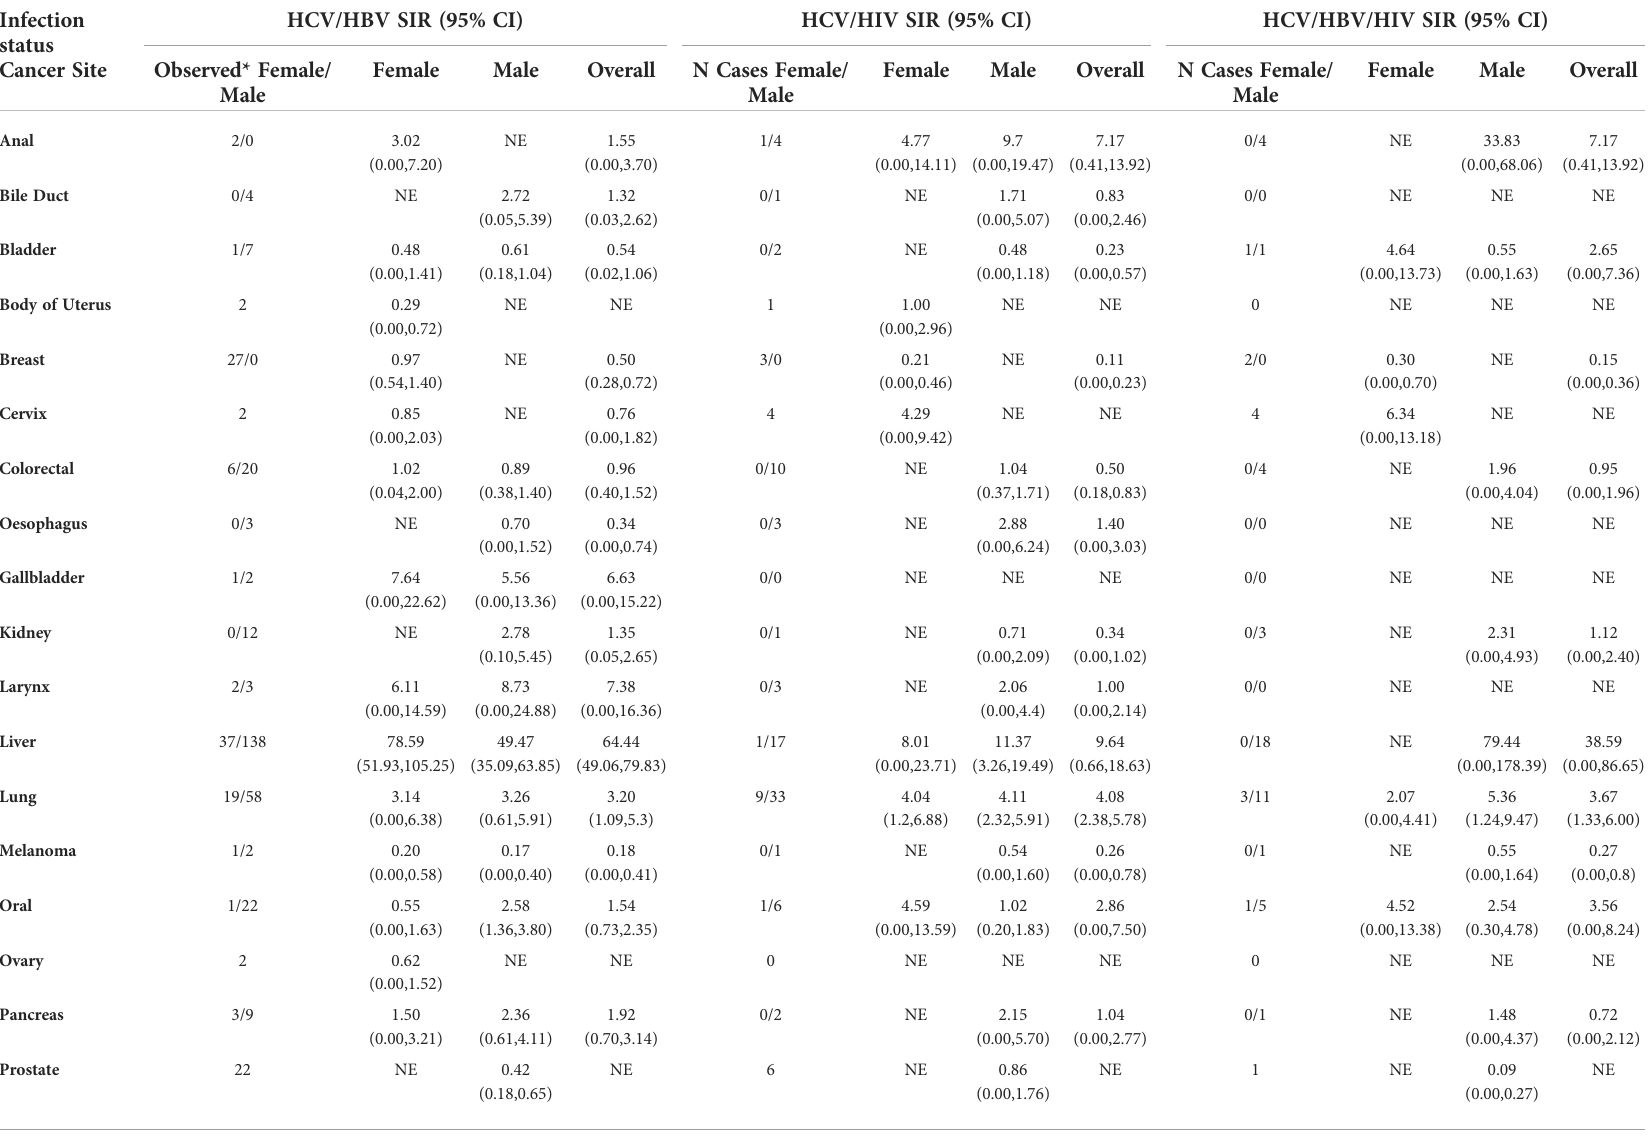
TABLE 3 Overall and gender-strati fi ed standardized incidence rates (SIRs) of cancer among HCV/HBV and HCV/HIV co-infected and HCV/HBV/HIV triple infected